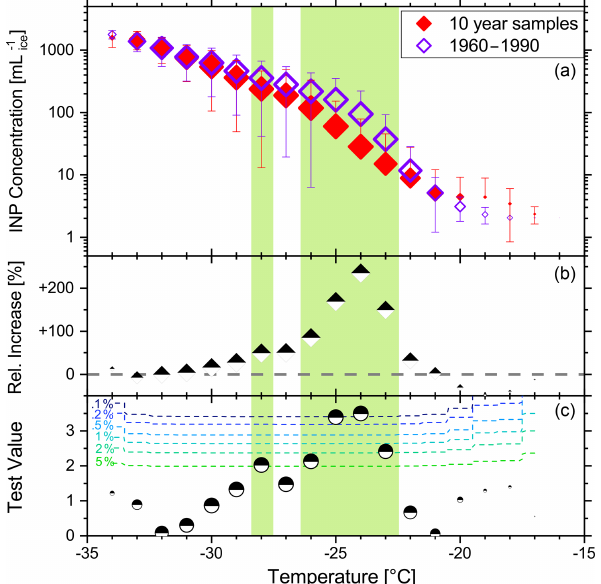
Figure 9. (a) Average INP concentrations ± standard deviation (er- ror bars) of the 10-year samples (red) and the modern-day sam- ples (purple). Negative error bars are not shown, when the stan- dard deviation is greater than the average. (b) Relative difference in the INP concentration between both groups. Positive values mean modern-day samples are higher. (c) Test values of a two-sided t -test to evaluate whether the average INP concentrations of both groups are significantly different from each other. Dotted colored lines in- dicate the significance level of the test. Average INP concentrations that differ significantly from each other at p< 0.05 are highlighted in green. Symbol sizes in all panels correspond to the respective number of ice-active samples at each temperature (maximum num- ber for 10-year samples: N = 58; maximum number for 1960–1990 samples: N = 31). Note that the 1630 sample is excluded from this